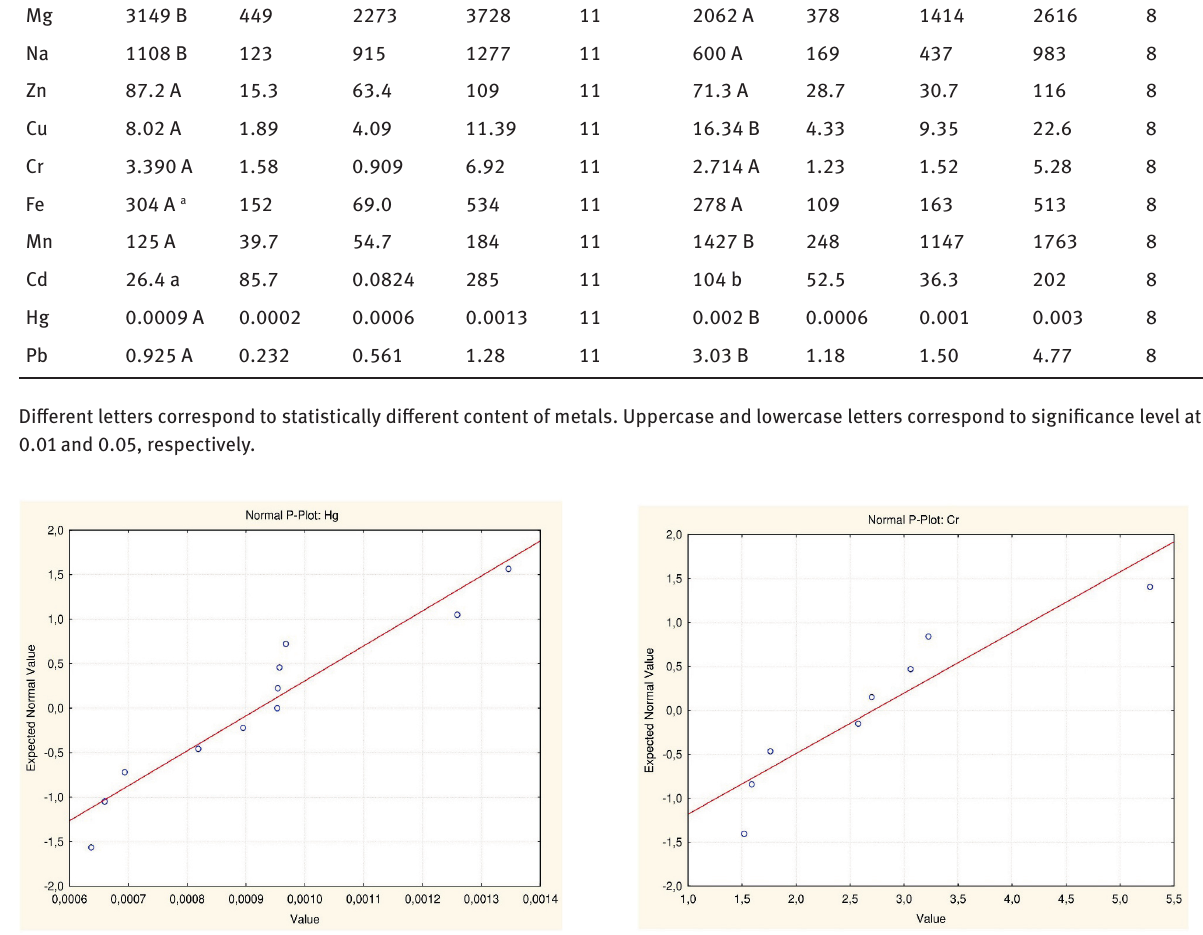
Figure 1: Normality data test for mercury in chamomile samples. Figure 2: Normality data test for chromium in green tea